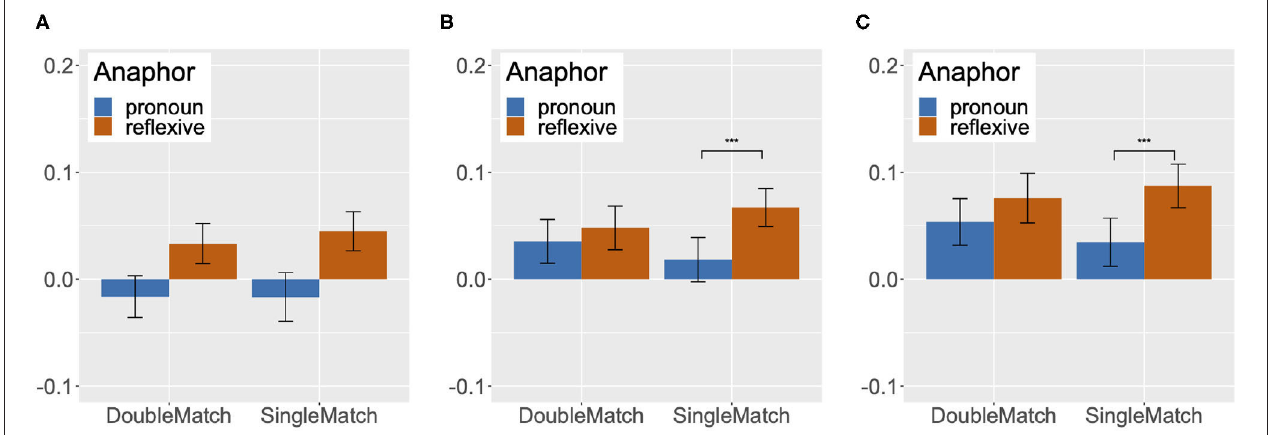
FIGURE 4 | Difference between looks to accessible and inaccessible antecedent images in single/double match condition, grouped into 300 ms time periods from 300 ms after the onset of the target anaphor to 1,200 ms after the onset, Experiment 2. (A) BT score, 301-600. (B) BT score, 601-900. (C) BT score, 901-1200.